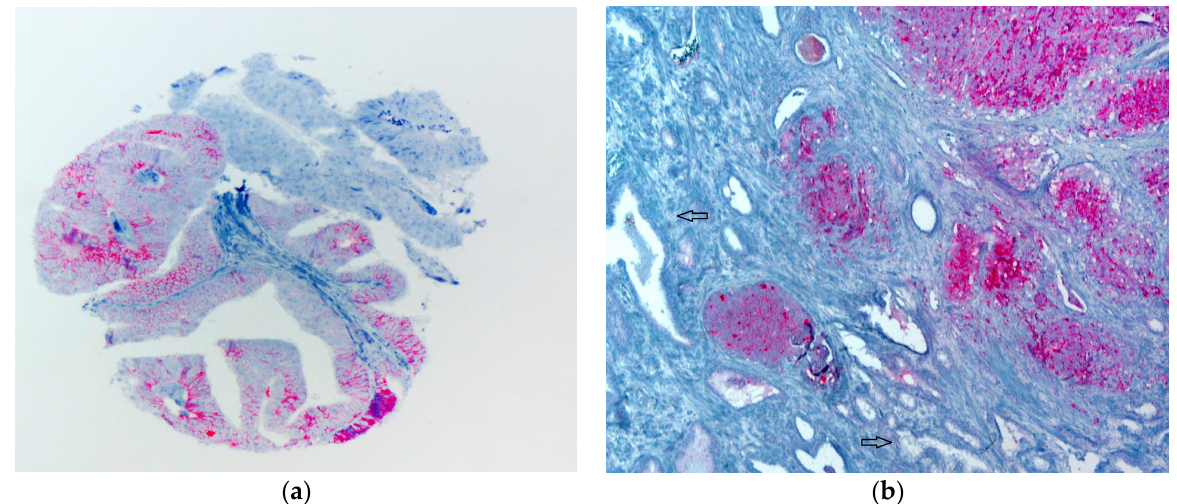
Figure 1. THSD7A shows membranous and cytoplasmic staining pattern. ( a ) Tumor cells with 2+ and 3+ staining. ( b ) Whole slide, tumor cells with strong THSD7A positivity, and the adjacent non-tumor tissue is THSD7A-negative (arrows) with a magnification of 100×.